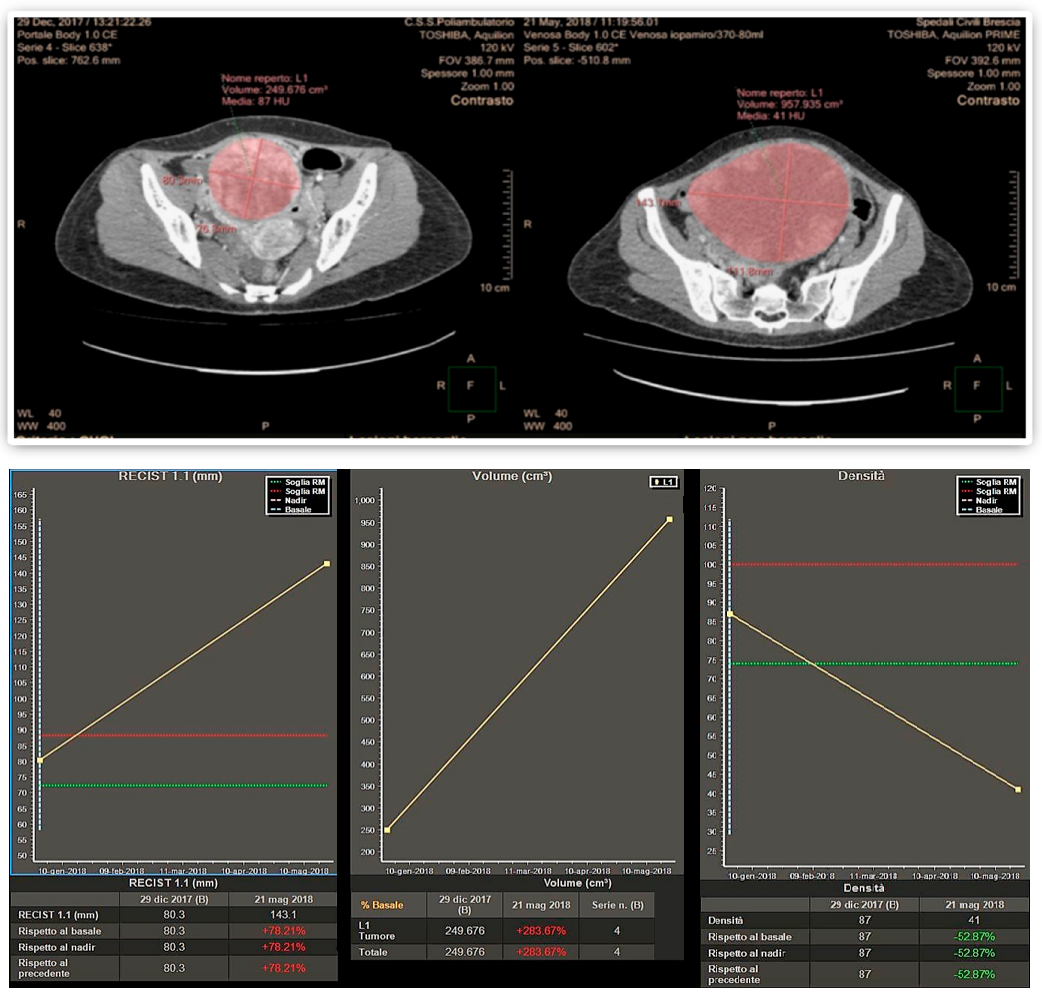
Figure 1. Disagreement in response assessment within the three criteria: according to Choi, the decrease in tumor attenuation was evaluated as a partial response, while according to both Volume and RECIST 1.1 its increase in planar dimensions and volume resulted in Progressive Disease. Table 2. Progression free survival (PFS) univariate analysis according to RECIST 1.1, Choi and volume staging